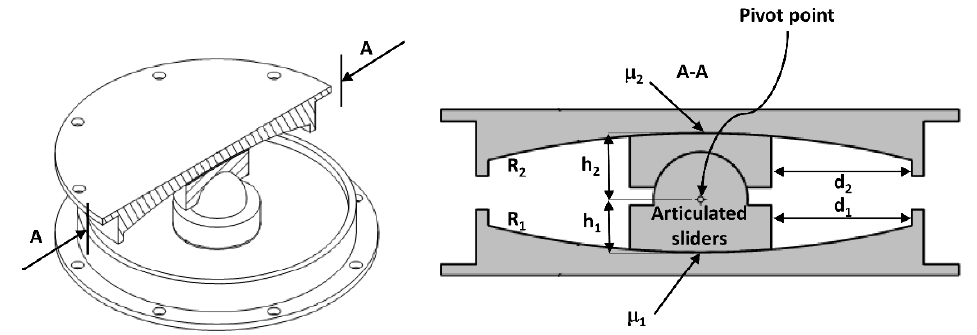
Figure 1. Schematic of the double friction pendulum bearing and its cross-section. The spring stiffness is calculated based on the effective radius 𝑅 𝑒𝑓𝑓𝑖 of the spherical surface that represents the linear restoring behaviour (i.e. restoring force), 𝑘 𝑏𝑖 = 𝑊/𝑅 𝑒𝑓𝑓𝑖 , with 𝑅 𝑒𝑓𝑓𝑖 = 𝑅 𝑖 − ℎ 𝑖 , where 𝑊 is the total weight acting on the bearing, 𝑅 𝑖 is the radius of curvature 𝑖 , and ℎ 𝑖 is the height from the centre of the pendulum to the surface of curvature 𝑖 (see Figure 1).